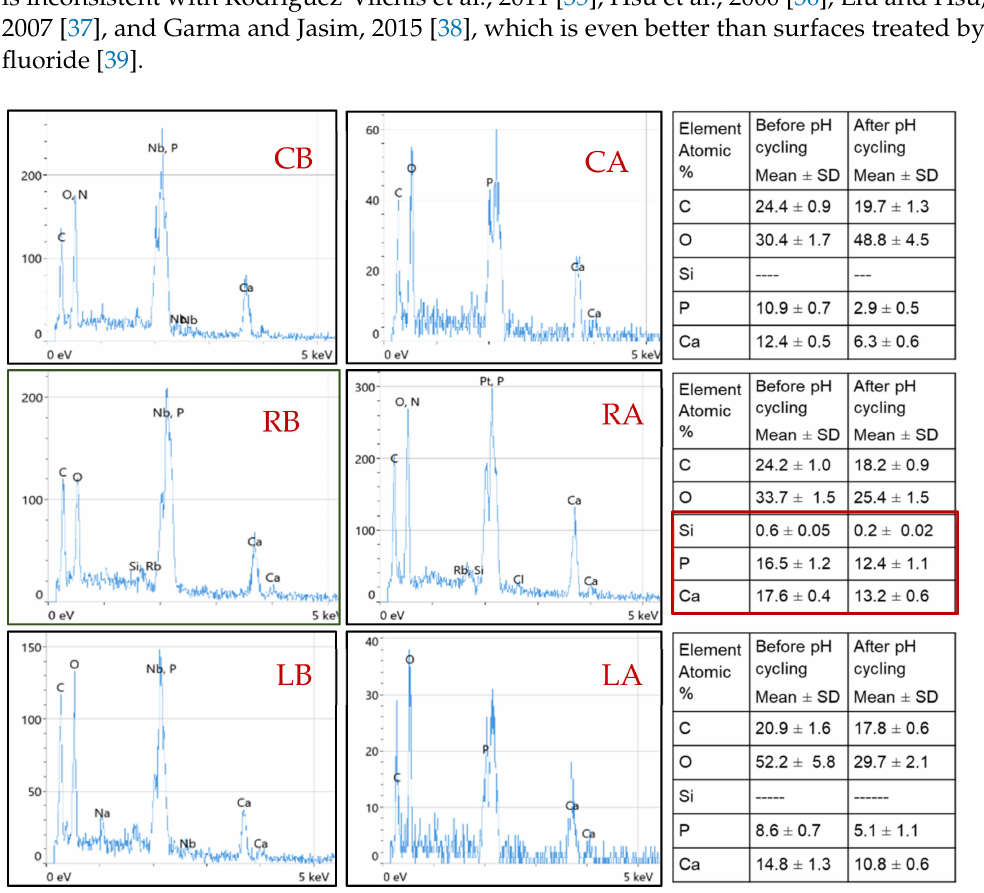
Figure 6. The EDX analysis of the control group (without treatment) before and after pH-cycling (CB, CA), Regenerate-treated surfaces (RB, RA), and CO 2 -treated surfaces (LB, LA). The mineral components (calcium and phosphorus ions) are reduced in all groups after pH-cycling; however, it was higher in Regenerate group (red square) with the presence of silica that is not seen in other groups. In accordance with the literature [21,40], this study supports the presence of a